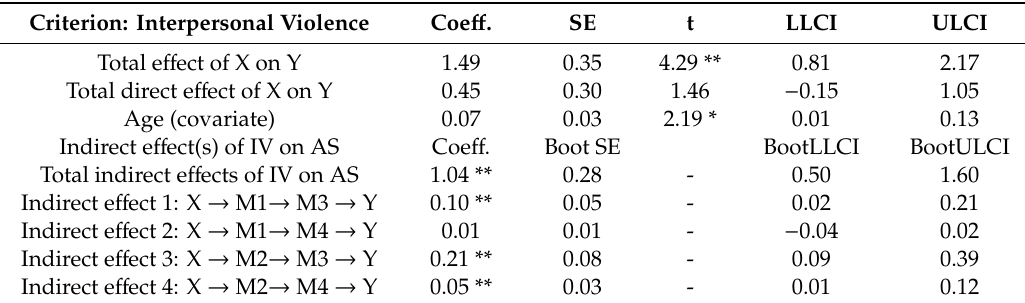
Table 2. Total, direct, and indirect e ff